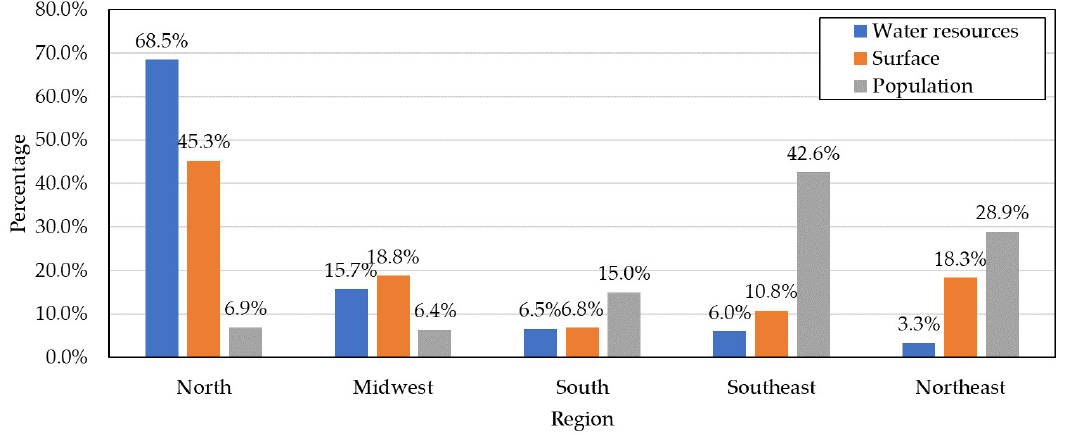
Figure 2. Distribution of water resources in the regions of Brazil [6].